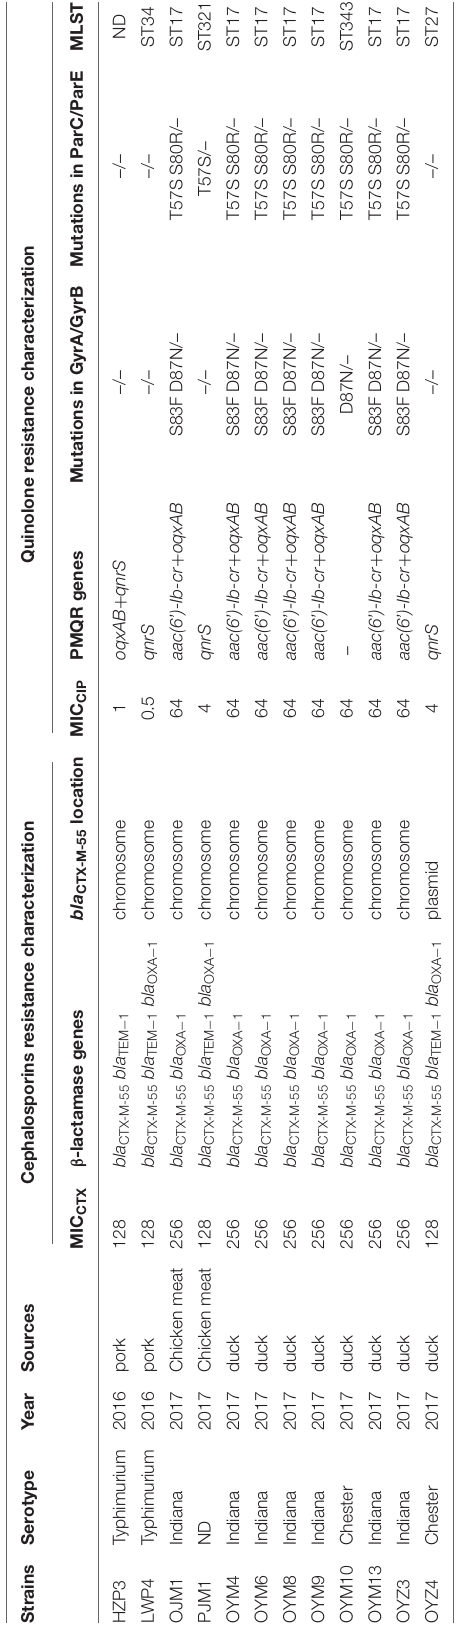
( Figure 2 ). Two narrow-spectrum β -lactamase gene, bla TEM − 1 and bla OXA − 1 and PMQR gene qnrS also co-transferred with bla CTX - M - 55 in the transconjugants ( Table 2 ). Analysis of the whole genome assembly of PJM1 identified the bla CTX - M - 55 present within an 11 kb contig with 100% identify to plasmid pCSFA1096, previously identified from Salmonella in